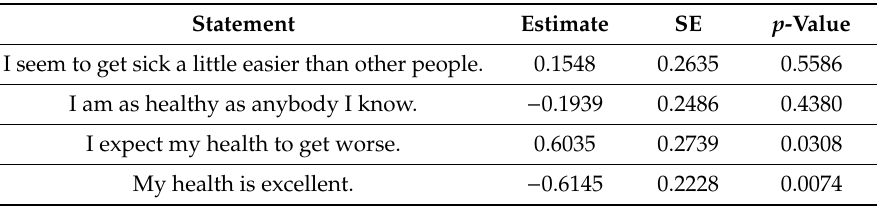
Table 9. Coe ffi cient estimate for airport region for linear mixed models adjusted for age, sex, and BMI for the listed health questions. Response categories were (5) definitely true, (4) mostly true, (3) don’t know, (2) mostly false, and (1) definitely false.